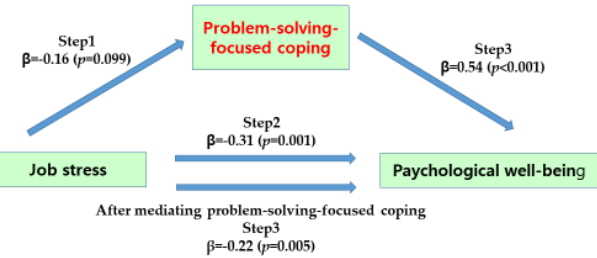
Figure 2. Mediating effect of problem-solving-focused coping of Figure 2 . Mediating effect of problem-solving-focused coping of participants .